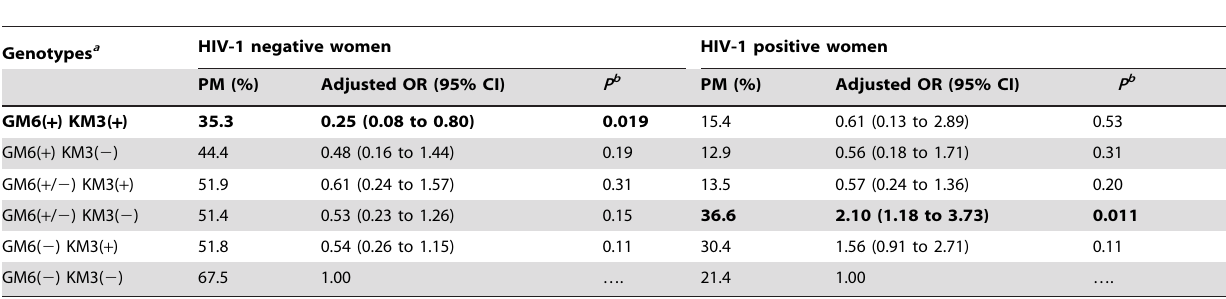
Table 5. Effect of combined GM6 and KM3 genotypes on the risk for PM in HIV-1 negative and positive women.